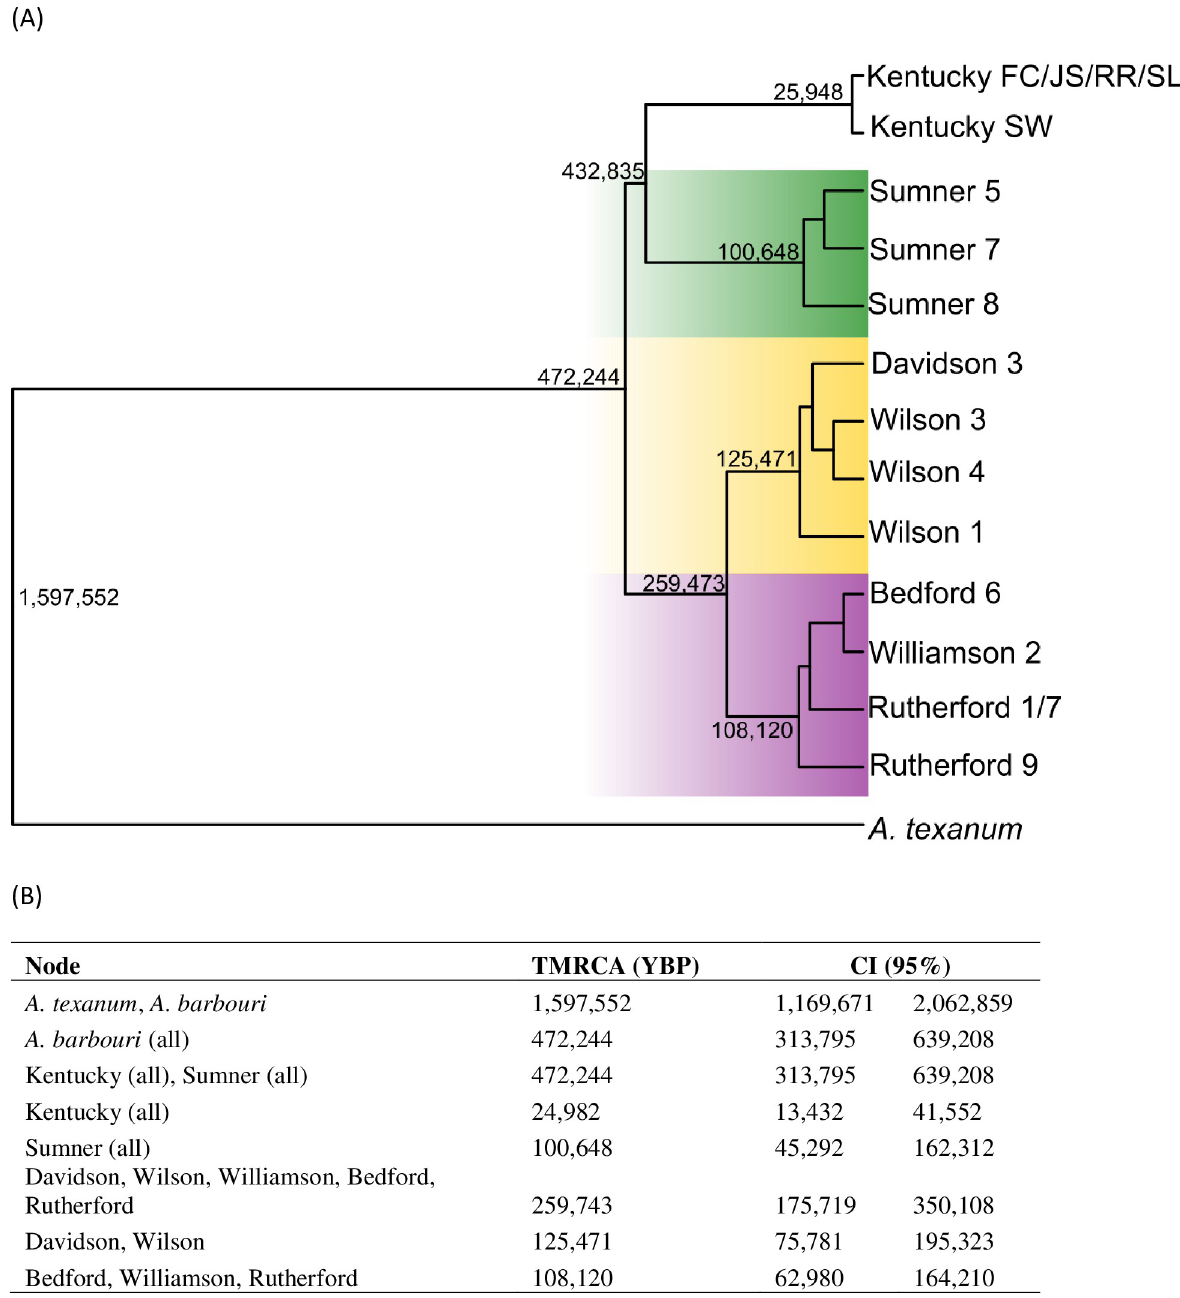
Fig 6. Multispecies coalescent analysis of SNP genotypes. Species-tree (A) and divergence time estimates (B) from Bayesian multispecies coalescent method as implemented in the software BPP. Numbers at nodes also indicate divergence time estimates (t). Divergence time parameter τ was converted to time in years before present (YBP) in the BPPR statistical package in R-studio. Shading in tree indicates ESU assignments as follows: Northern ESU (green), Central ESU (Yellow) and Southern ESU